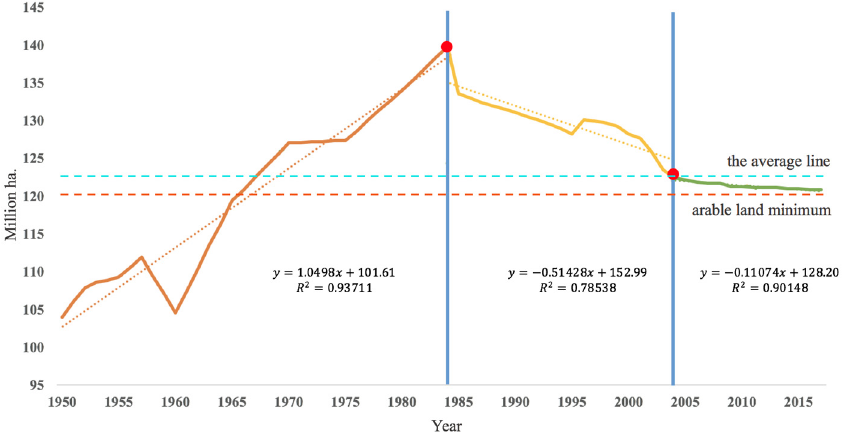
Figure 4. Regression analysis of farmland area changes in China between 1950 and 2017.